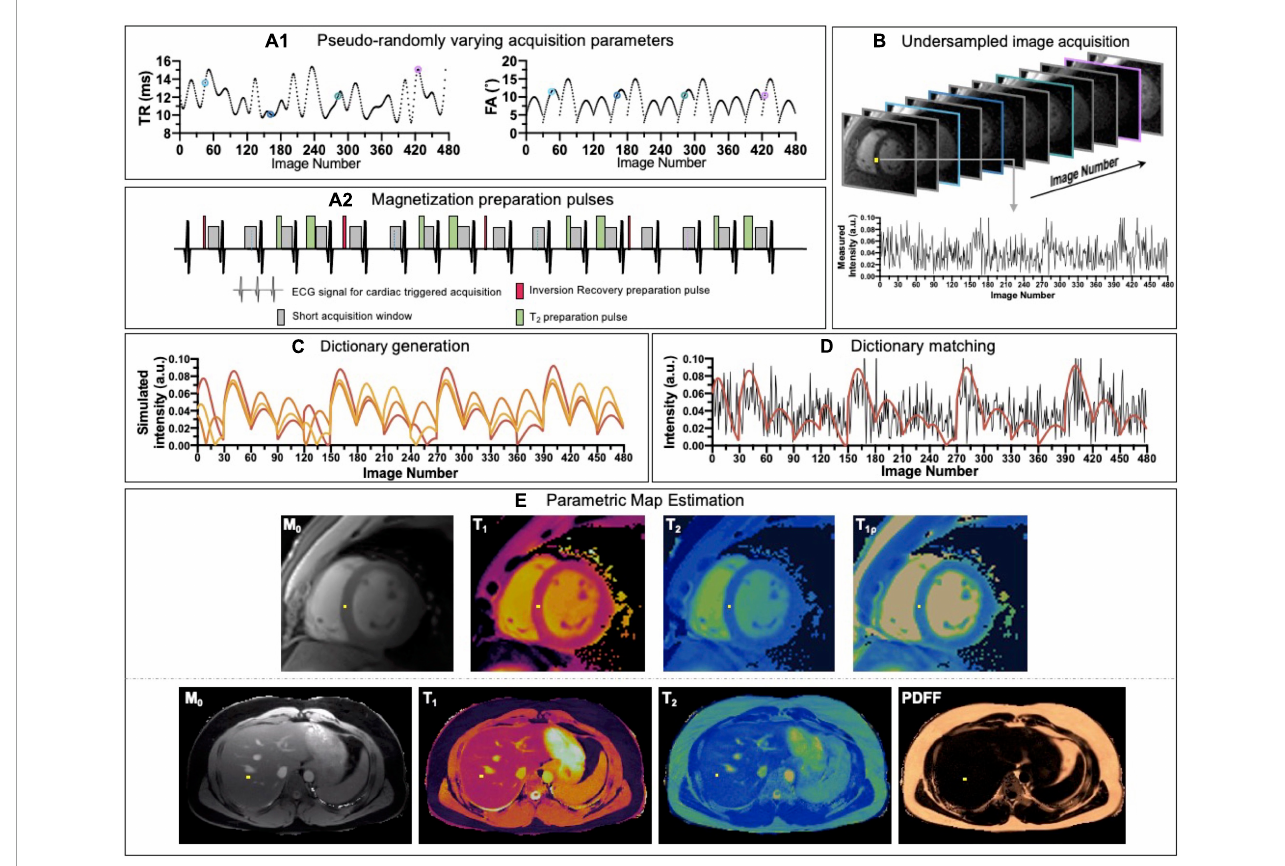
FIGURE8 Schematic overview of a cardiac/liver MRF framework. (A1) Acquisition parameters such as repetition time (TR) and variable flip angles (FA) may be pseudo-randomly varied throughout acquisition and (A2) magnetization preparation pulses are introduced to increment contrast weighing on the desired parameters. (B) Highly undersampled images are obtained, and (C) a dictionary of different signal evolutions for a range of T 1 /T 2 (and other parameters of interest) combinations are calculated in parallel. (D) Matching the temporal evolution of the signal measured with the dictionary will provide (E) inherently co-registered parametric maps of the scanned